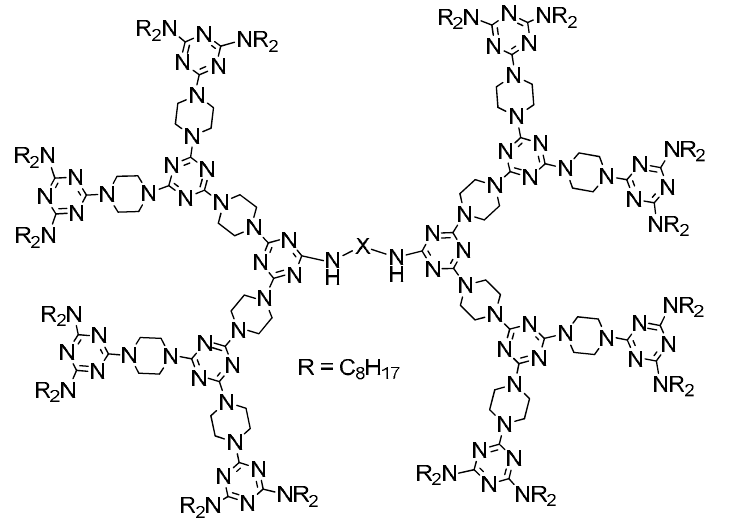
Figure 5. Structures of dendrimers ( 9 – 12